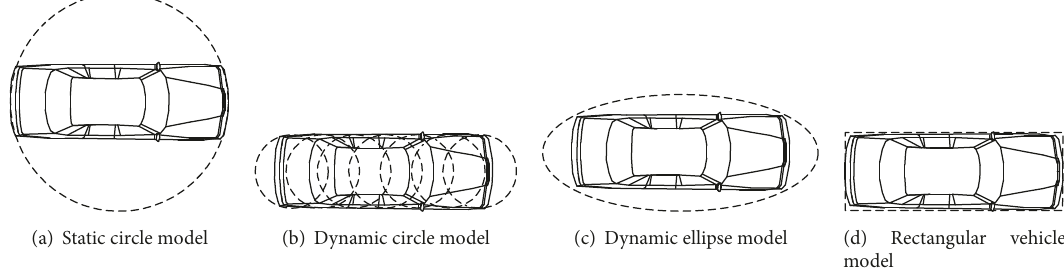
Figure 4: Schematic diagram of the different vehicle models.